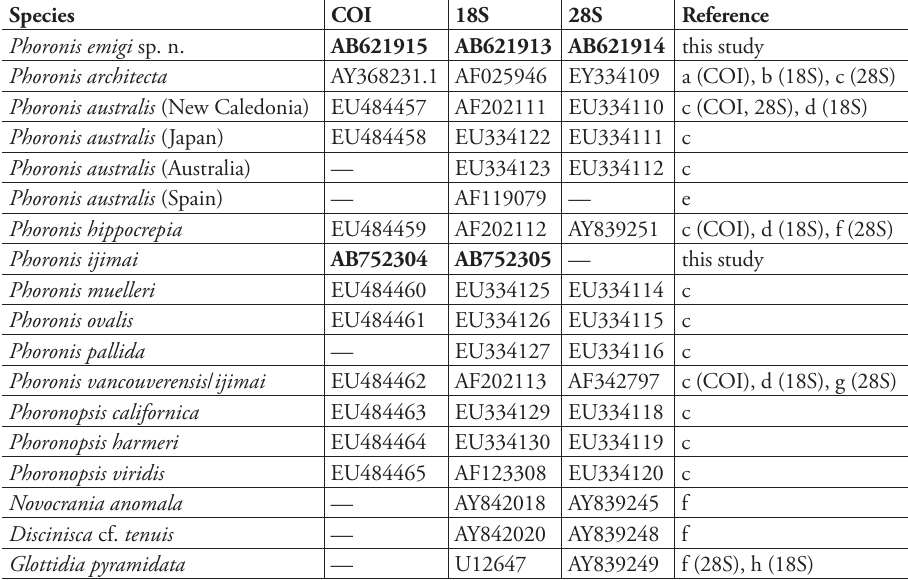
Table 1. Taxa included in the phylogenetic analyses and GenBank accession numbers for sequences. Sequences obtained in this study are in bold